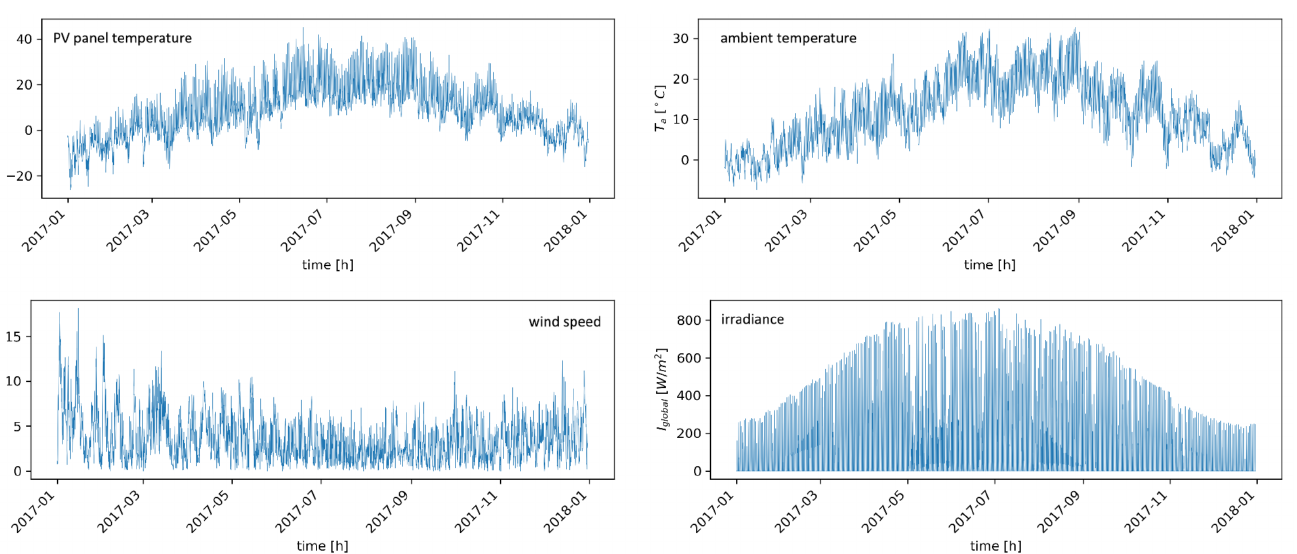
Figure 5. PV system efficiency characteristics. Meteorological data are from real measurements at the network location, Figure 6. The maximum measured irradiation was 906 W/m 2 . The calculated yearly production from 1 kWp of installed PV is 1080 kWh.